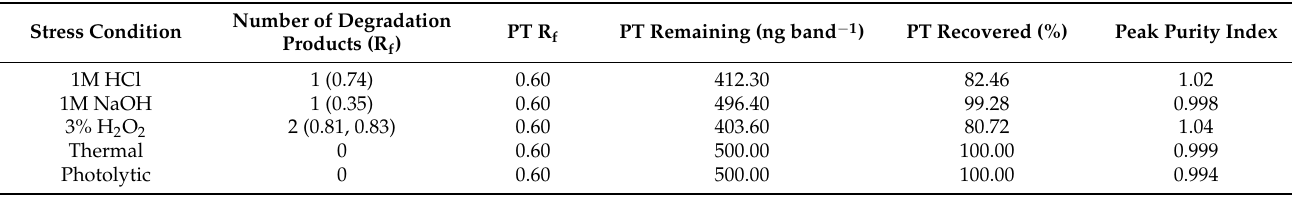
Table 6. Resulting data of selectivity/degradation studies of PT at various stress conditions for the sustainable RP-HPTLC method (mean ± SD; n =